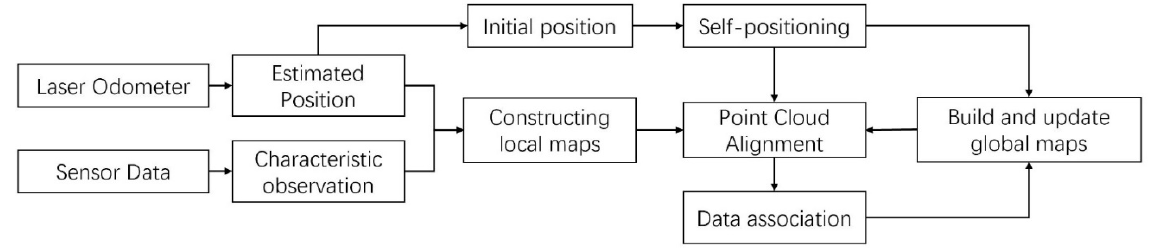
Figure 2. SLAM system flow chart.